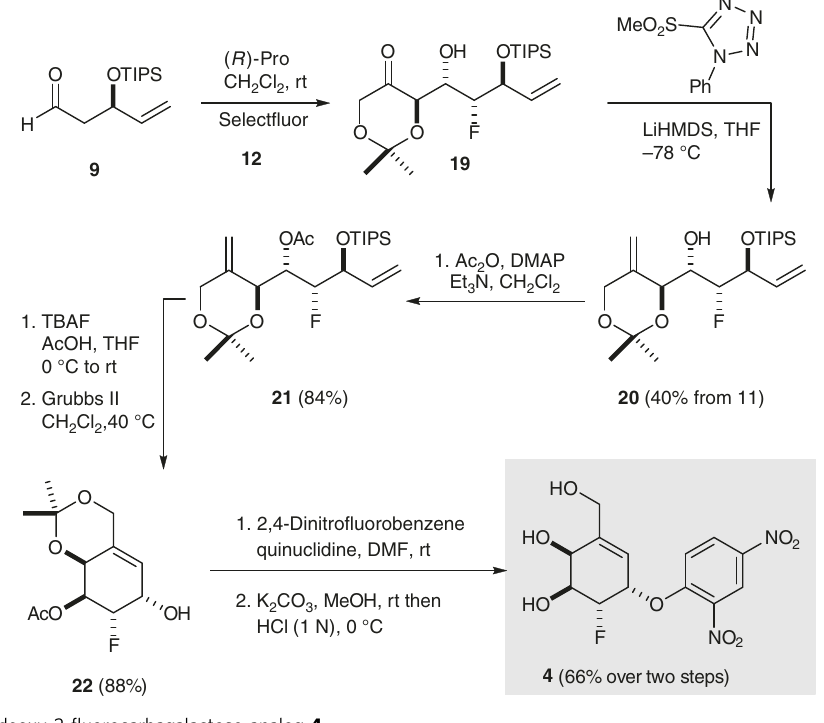
Fig. 4 Synthesis of the 2-deoxy-2- fl uorocarbagalactose analog 4